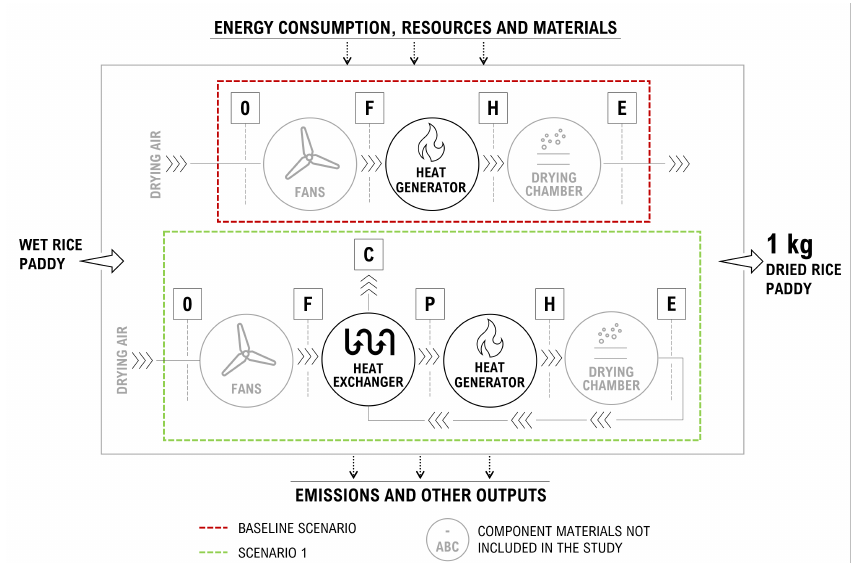
Figure 1. The drying cycles with system boundaries for the life cycle